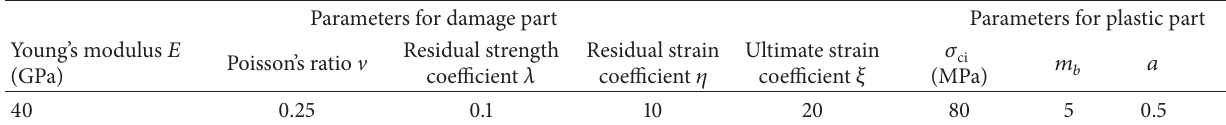
Table 1: Values of parameters for numerical simulation.